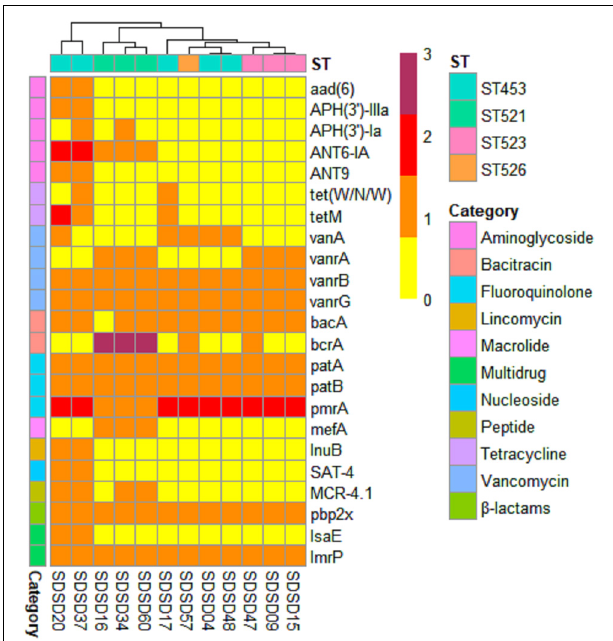
FIGURE 5 | Heatmap of antimicrobial resistance (AMR) gene distribution in 12 Streptococcus dysgalactiae subsp. dysgalactiae (SDSD) isolates. A total of 23 AMR genes were identified by CARD (Comprehensive Antibiotic Research Database) in all 12 SDSD strains. The copy number, ranging from 0 to 3, was indicated by yellow to red. Ten main AMR categories were marked with colored bars along the Y-axis. The phylogenetic tree based on the presence of AMR genes in the isolates was presented as a cladogram in the panel along the